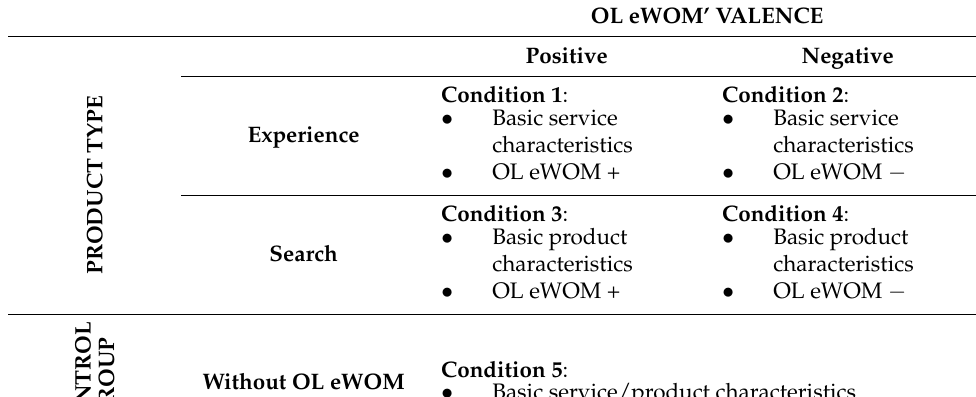
Table 2. Experimental manipulation: OL eWOM, product type, and eWOM valence.